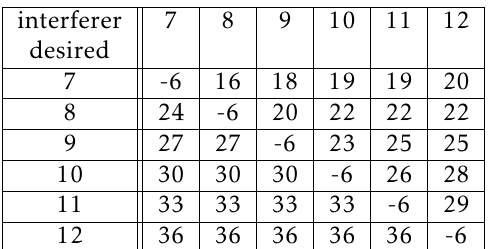
Table 1. Cochannel rejection (dB) for all combinations of spreading factor for the desired and interferer user